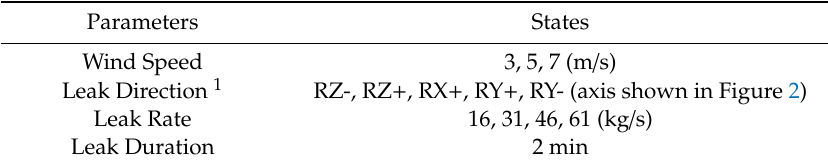
Table 3. Parameters and states